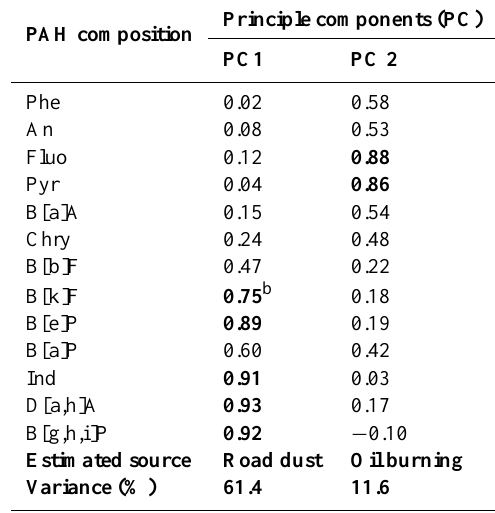
Table 3. Rotated component matrix of 13 PAHs from Khao Lak coastal sediments a